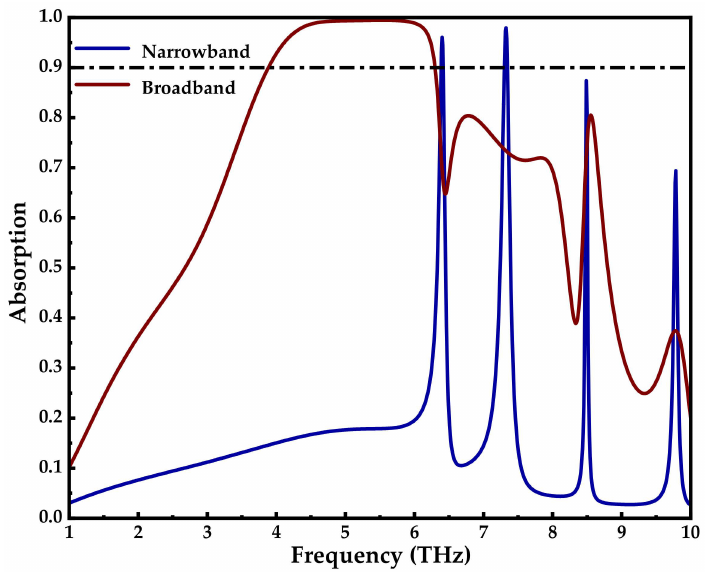
Figure 3. Broadband absorption curve of VO 2 in metallic phase (red line) and narrowband absorption curve of VO 2 in insulating phase (blue